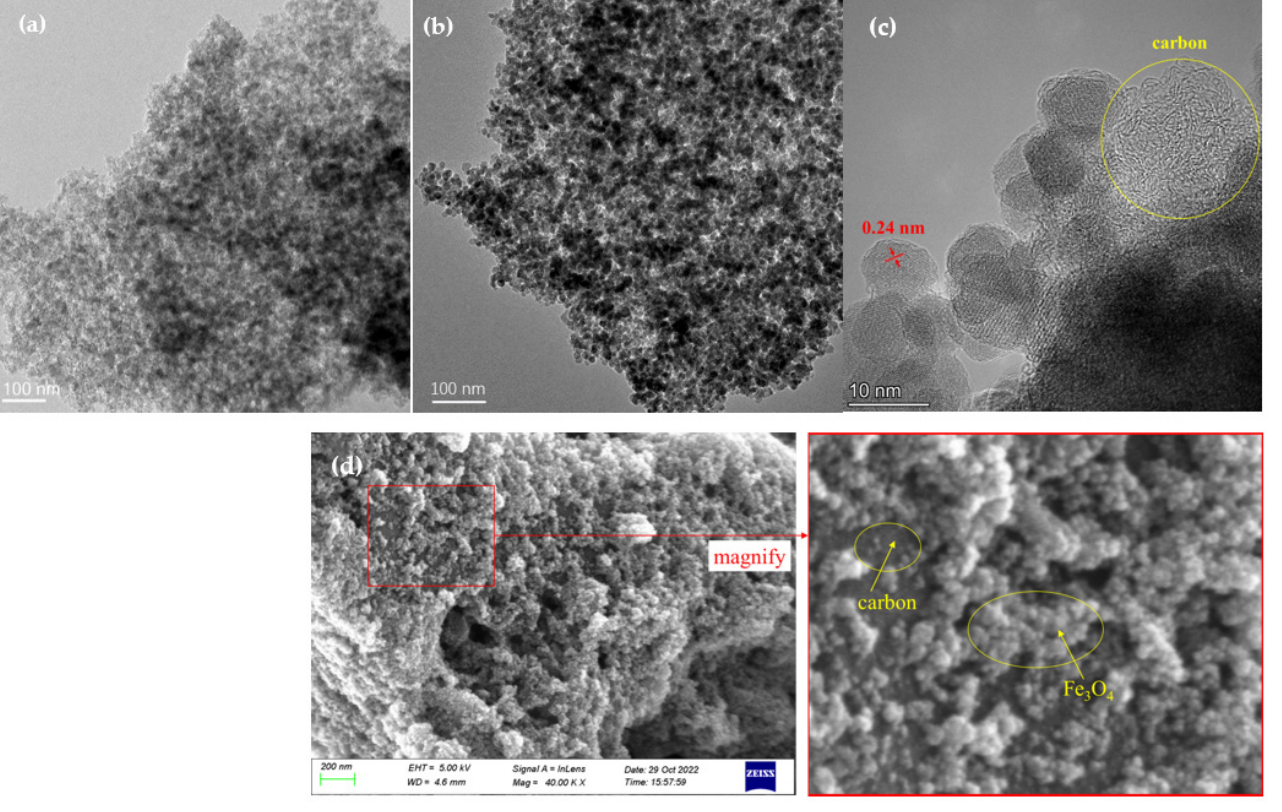
Figure 3. TEM image of MMC ( a ), TEM image of MOMMC ( b ), HRTEM image of MOMMC ( c ), and SEM image of MOMMC with red region magnified ( d ).